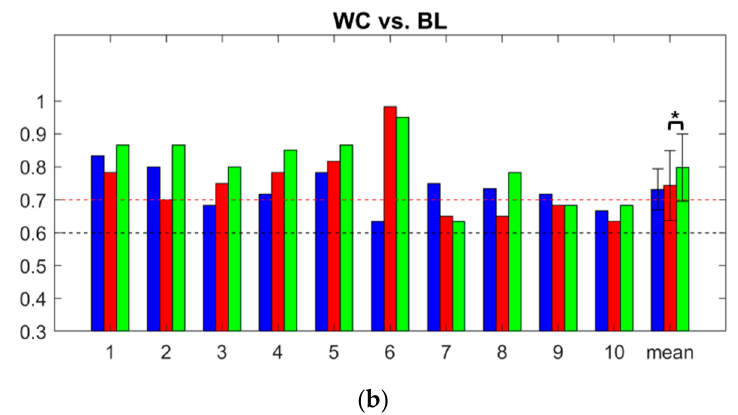
Figure 6. Individual and average pseudo-online binary classification accuracies of the EEG (blue), NIRS (red), and hBCI (green) for MA vs. BL ( a ) and WC vs. BL ( b ). The error bars indicate the standard deviations of the individual accuracies. The red and black dashed lines are the threshold of the effective binary BCI (>70%) and the theoretical chance level of 60% ( p < 0.05) [38]. The significance difference between the average classification accuracies of the EEG, NIRS, and hBCI are denoted by an asterisk (* corrected p < 0.05).